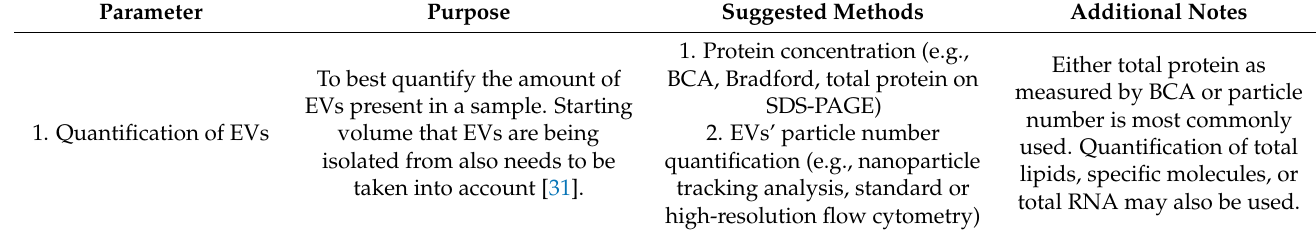
Table 1. Characterization of EVs. The purpose of this table is to summarize the parameters outlined by MISEV2018. For optimal characterization of EVs, please refer to the original article by Thery et al. for detailed information about MISEV2018 guidelines [31]. The first column is the four different parameters that must be assessed when studying EVs; the second column gives the reasoning and purpose of assessing this parameter; the third column provides methods suggested by MISEV2018; and the fourth column cites any additional notes highlighted in the publication